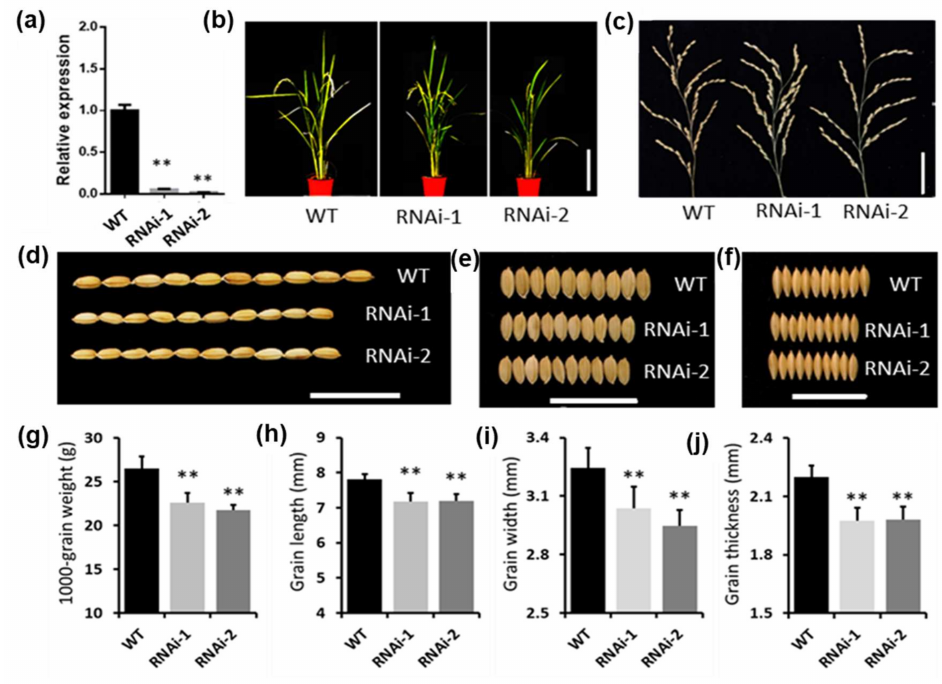
Figure 6. Phenotype analysis of RNAi lines of MSTRG.19480. ( a ) Expression level of MSTRG.19480 in RNAi lines. ( b – f ) Phenotype of MSTRG.19480 RNAi lines and wild-type (WT) plants, plant height (scale bar = 20 cm) ( b ), panicles (scale bar = 5 cm) ( c ), grain length (scale bar = 1 cm) ( d ), grain width (scale bar = 1 cm) ( e ), grain thickness (scale bar = 1 cm) ( f ). ( g – j ) Statistical analysis of grain weight ( g ), grain length ( h ), grain width ( i ) and grain thickness ( j ) in MSTRG.19480 RNAi lines and WT. Asterisks indicate statistically significant differences compared with WT by Student’s t test (** p < 0.01; n =